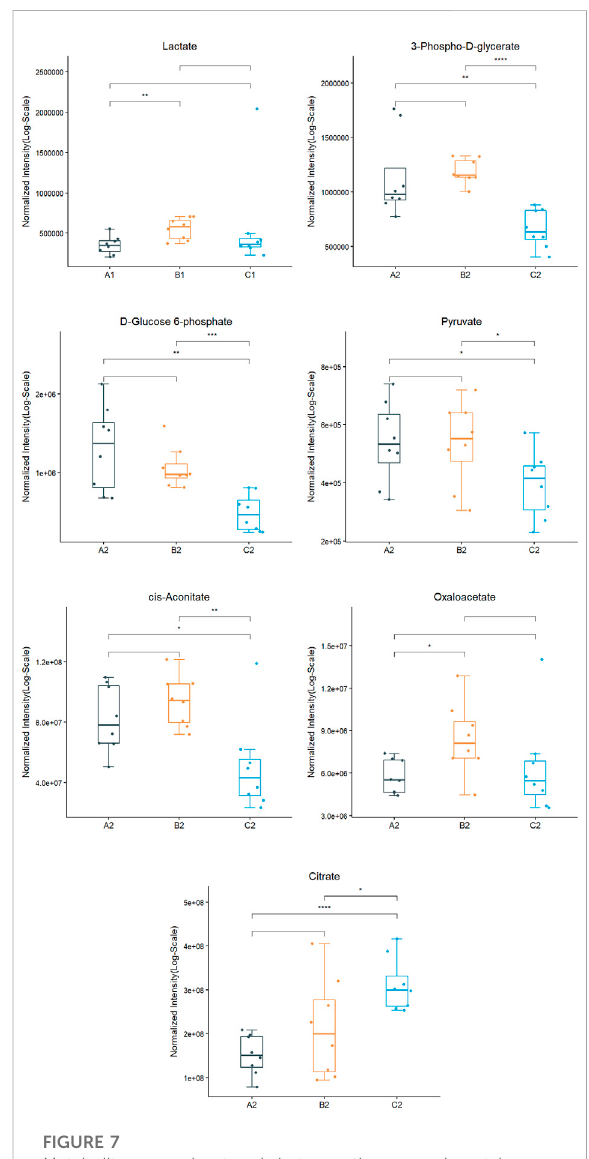
FIGURE 7 Metabolite expression trends between three experimental conditions. (A1: PL pre-exercise; B1: ES pre-exercise, C1: GS pre- exercise. A2: PL post-exercise; B2: ES post-exercise, C2: GS